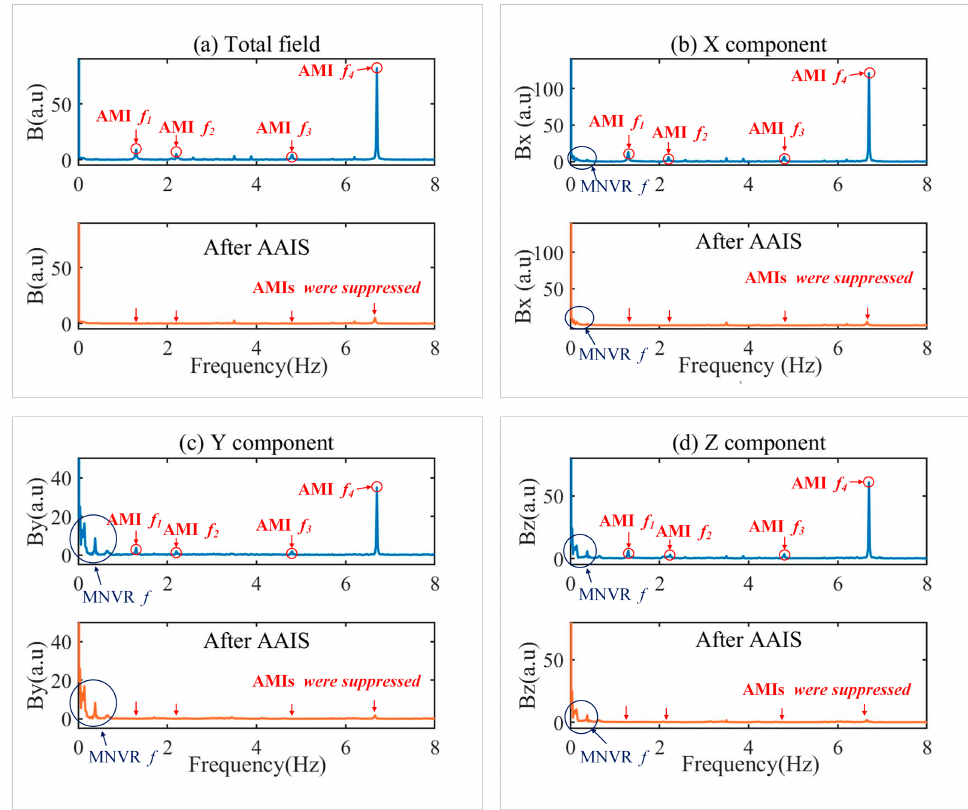
Figure 11. The frequency spectrum of the data measured by the magnetometer and processed by the AAIS algorithm. ( a ) The total magnetic field; ( b ) The X component; ( c ) The Y component; ( d ) The Z component. AMI is the abbreviation for alternating magnetic interference. MNVR is the abbreviation for maneuver. f means the frequency.